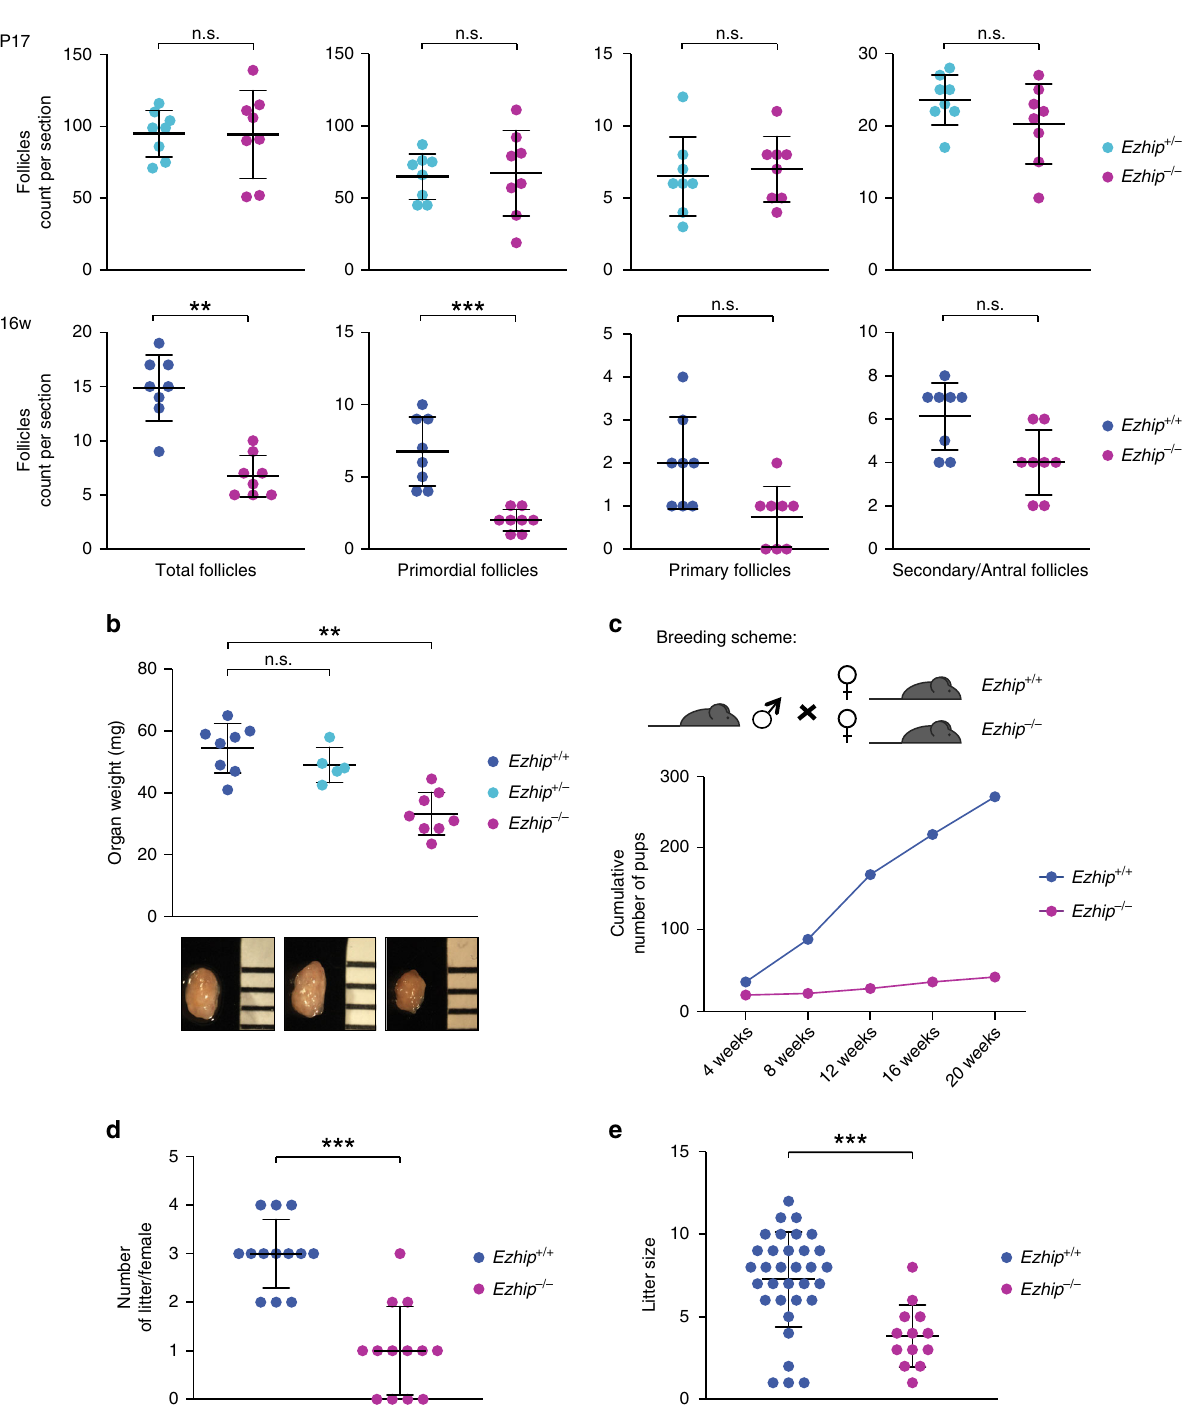
Fig. 8 Ezhip knockout affects adult female fertility. a Follicle counting on WT vs. Ezhip − / − 2 week-old female slides and 16-week-old, upper and lower panel, respectively (eight slides counted for each genotype, mean ± s.d.). Left panel corresponds to the total number of follicles, then each panel corresponds to a different folliculogenesis step: primordial follicles, primary follicles, secondary/antral follicles. Y- axis represents the average follicles number per slide, genotype is indicated in the legend. b Average ovaries weight (mg) in adult females (4 – 5-month-old, mean ± s.d., each dot represents an independent female). c – e Fertility of WT and Ezhip − / − females monitored during 5 months. c Cumulative number of pups per genotype depending on time ( n = 13 cages, breeding scheme represented on top). d The number of litters per female during the 20 weeks monitoring. e Litter size. a , b , d , e Signi fi cance: unpaired, non-parametric test of Kologorov – Smirnov, *** P ≤ 0.001, ** P ≤